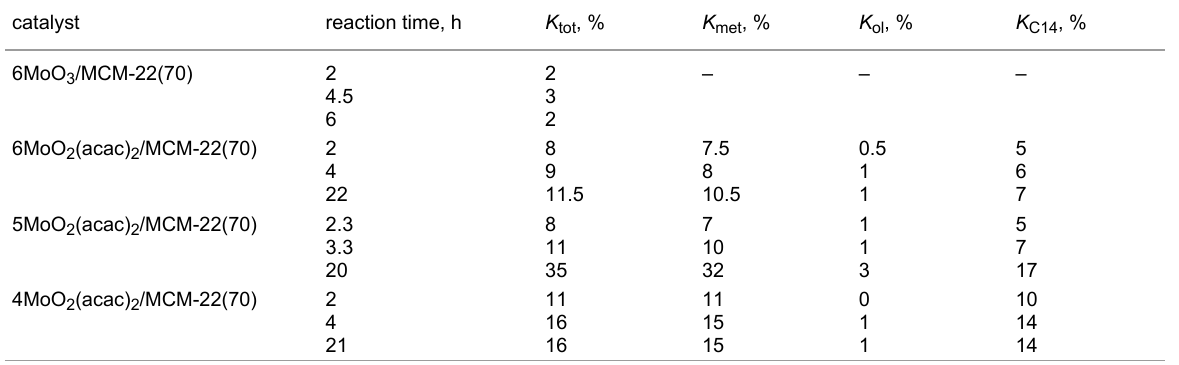
catalyst reaction time, h K tot , % K met , % K ol , % K C14 , %